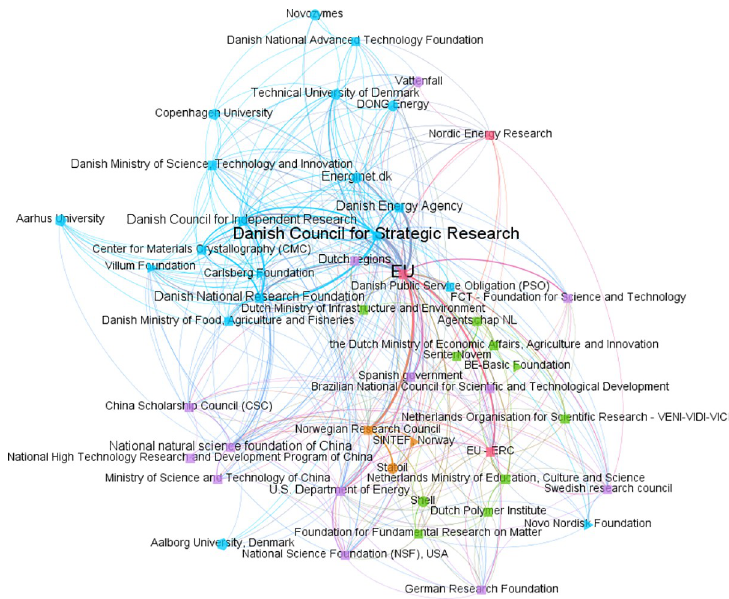
Fig 3. Co-funding network for Renewable Energy Research, all affiliation countries, articles 2009–18. Origin colours: Blue = affiliated-Denmark; green = affiliated-Netherlands; orange = affiliated-Norway; purple = affiliated other countries; red = supranational. Type shapes: Triangle = non-profit; square = public; circle = private; pentagon = university. Node size = number of FAs mentioning that funding instrument; ties = instrument co- occurrences within the same article’s FAs.